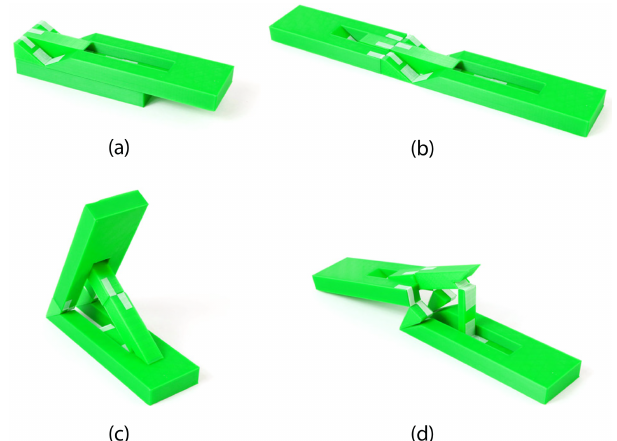
Figure 14. Flat-foldable planar deploying strut ThUDS with links 2 and 3 split. Shown (a) flat folded, (b) flat, (c) deployed, and (d) in an undesired state due to the added degrees of